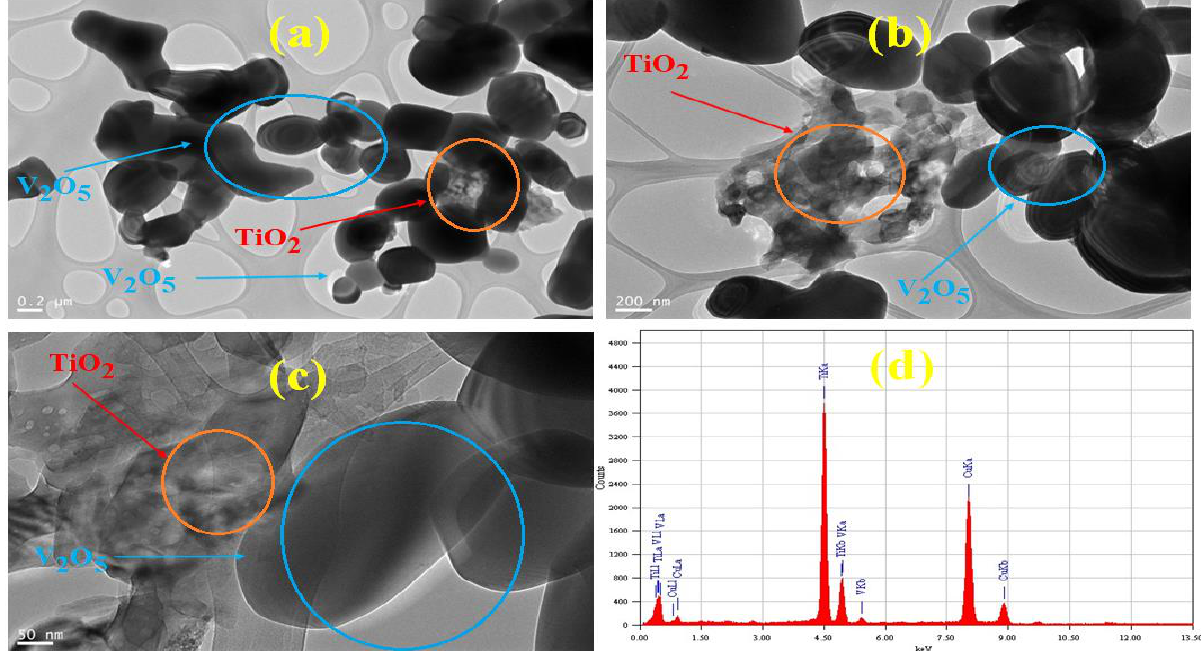
Figure 2. ( a – c ) TEM images at different magnifications and ( d ) EDX of the V@TiO 2 nanocomposite.